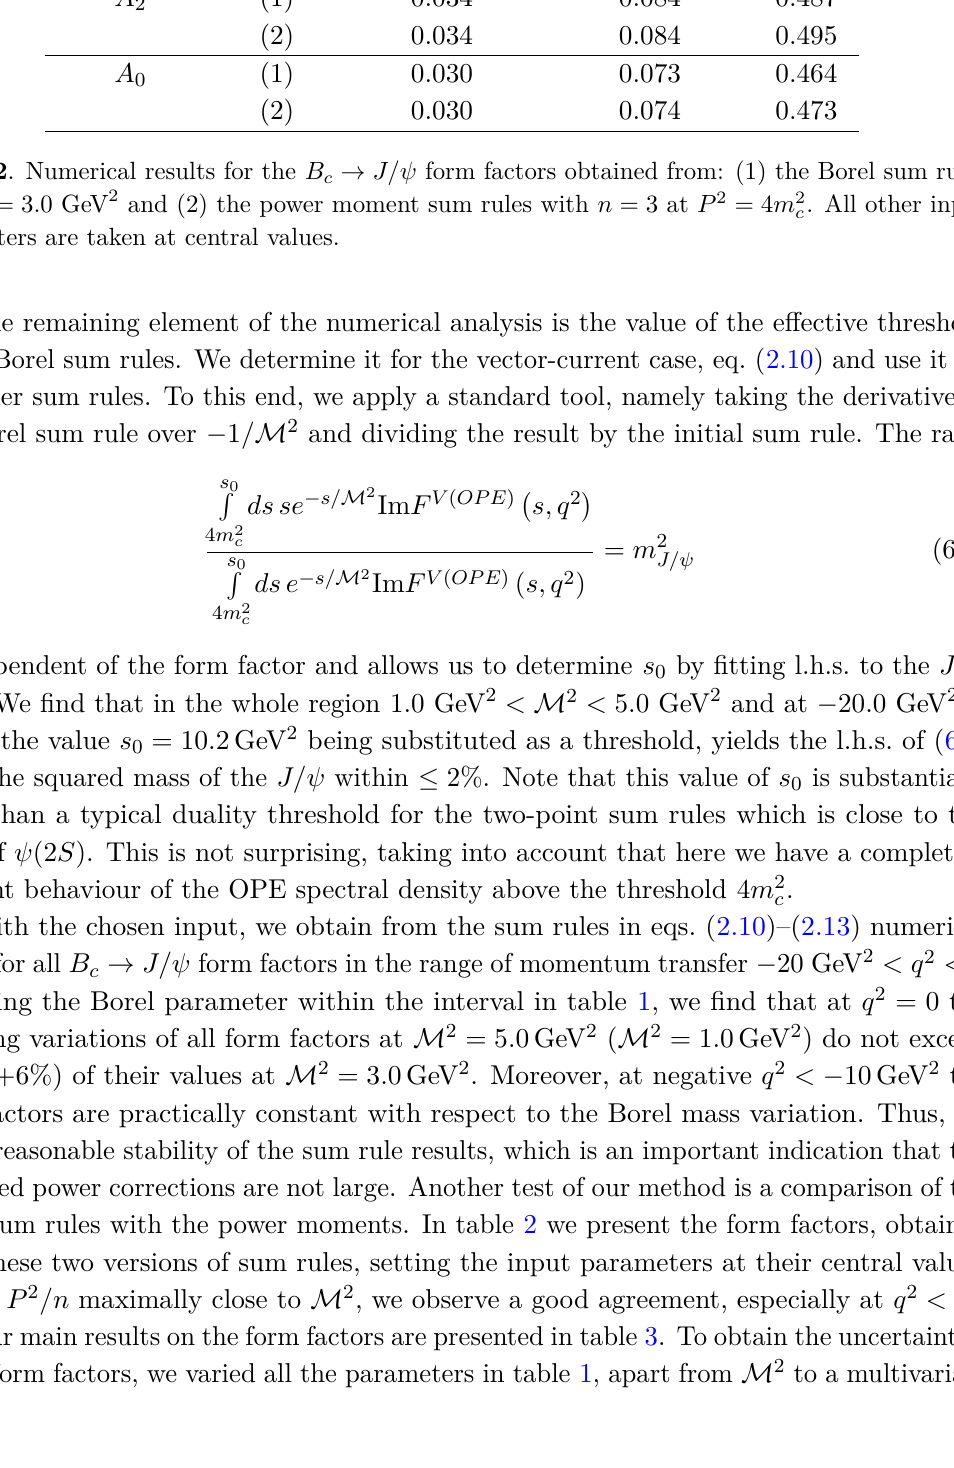
. All other input c